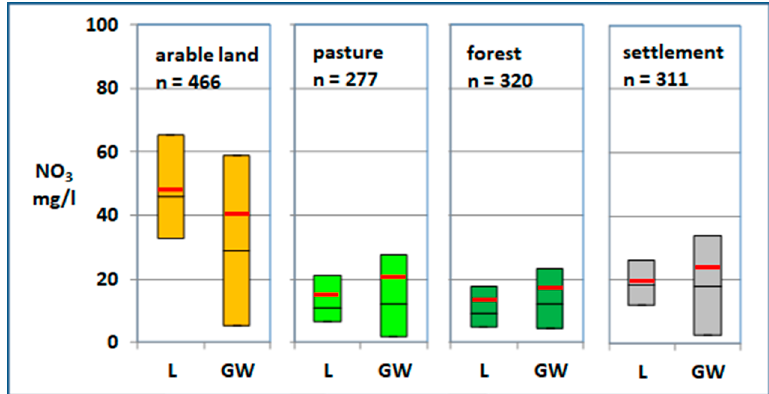
Figure 9. Comparison of modelled nitrate concentrations in the leachate (L) and observed nitrate concentrations in groundwater at monitoring stations (GW) for different land use types. The lower and upper end of the bars indicate the statistical distribution with the 25th percentile and 75th percentile, respectively, and the lines inside the bars mark the median (black line) and mean (red line).